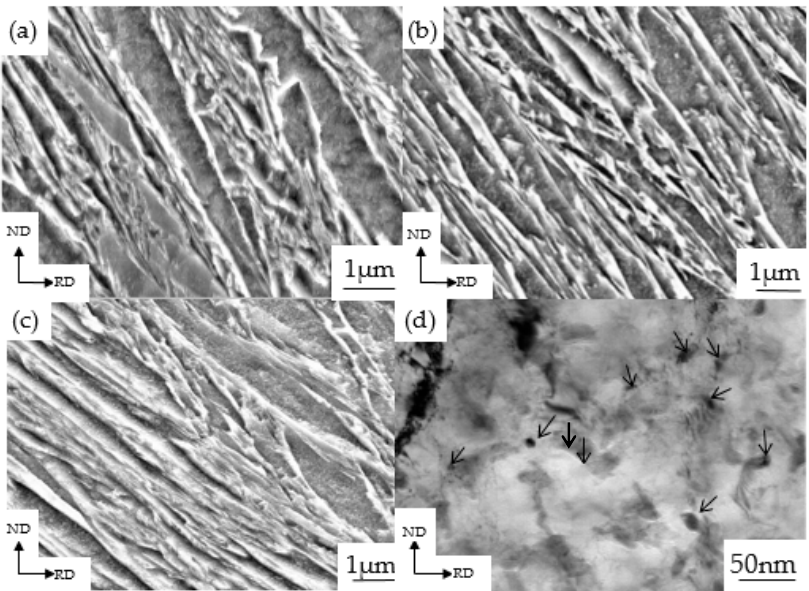
Figure 11. The SEM microstructures ( a – c ) and TEM microstructure ( d ) of the cold rolled sheets tempered at 120 °C for various time periods, ( a ) quenched specimens with subsequent aging for 5 h, ( b ) quenched specimens with subsequent aging for 36 h, ( c ) and ( d ) 30% cold rolled specimens with subsequent aging for 36 h (Arrows point to the precipitated nano-carbides).